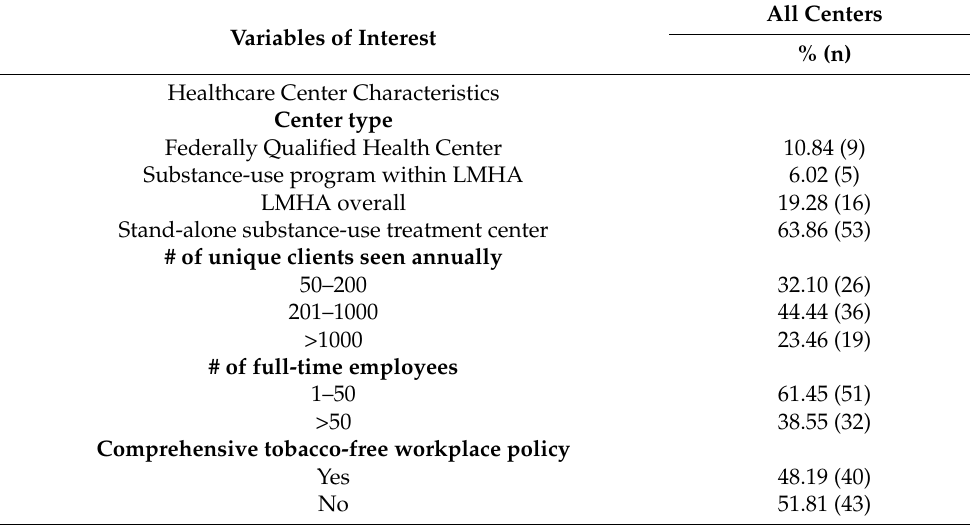
Table 1. Texas Healthcare Center Characteristics, Providers’ Perceptions on Concurrent Smok- ing/Tobacco Cessation and Non-Nicotine-Substance-Use Treatment, and Providers’ Provision of the 5A’s for Smoking